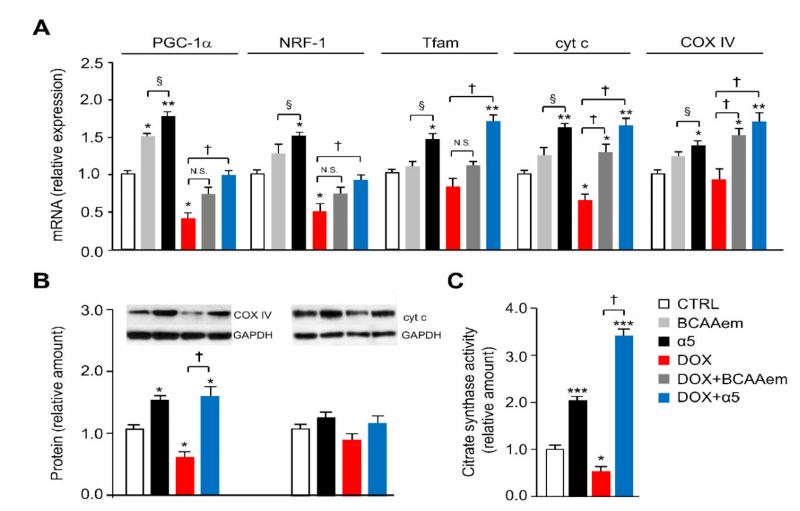
Figure 3. Specific amino-acid mixtures prevent mitochondrial dysfunction in HL-1 cardiomyocytes acutely exposed to DOX. ( A ) Mitochondrial biogenesis marker expression: peroxisome proliferator-activated receptor- γ coactivator 1 α (PGC1- α ), nuclear respiratory factor-1 (NRF1), transcription factor A (Tfam), cytochrome c (cyt c), and cytochrome c oxidase subunit IV (COX IV) mRNA levels were analysed by quantitative RT-PCR. Relative expression values for the untreated (CTRL) cells were taken as 1.0 ( n = 5 experiments). ( B ) COX IV and cyt c protein levels were detected by immunoblot analysis. The relative values were determined by densitometric analysis relative to GAPDH levels; values for untreated (CTRL) cells were taken as 1.0 ( n = 5 experiments). ( C ) Citrate synthase activity. The values were normalized to protein content ( n = 3 experiments). * p < 0.05, ** p < 0.01, and *** p < 0.001 vs. untreated cells; † p < 0.01 vs. DOX-treated cells; § p < 0.01 vs. BCAAem-treated cells. All data are presented as the mean ± SD.